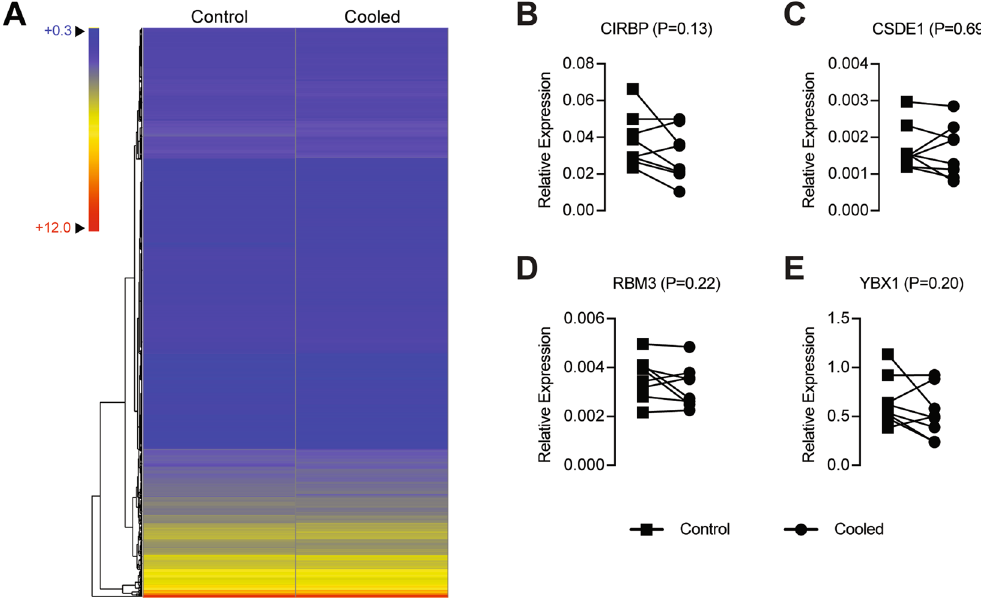
Figure 2. Heat map and gene expression. ( A ) Heatmap of microarray data from control and cooled muscles. Targeted gene expression measurements of the cold shock genes, ( B ) CIRBP, ( C ) CSDE1, ( D ) RBM3 and ( E ) YBX1, from control and cooled muscles. The expression of each gene was normalized to the stable housekeeping gene B2M. Differences were tested using paired t-tests, and p-values are indicated in each panel. N = 8